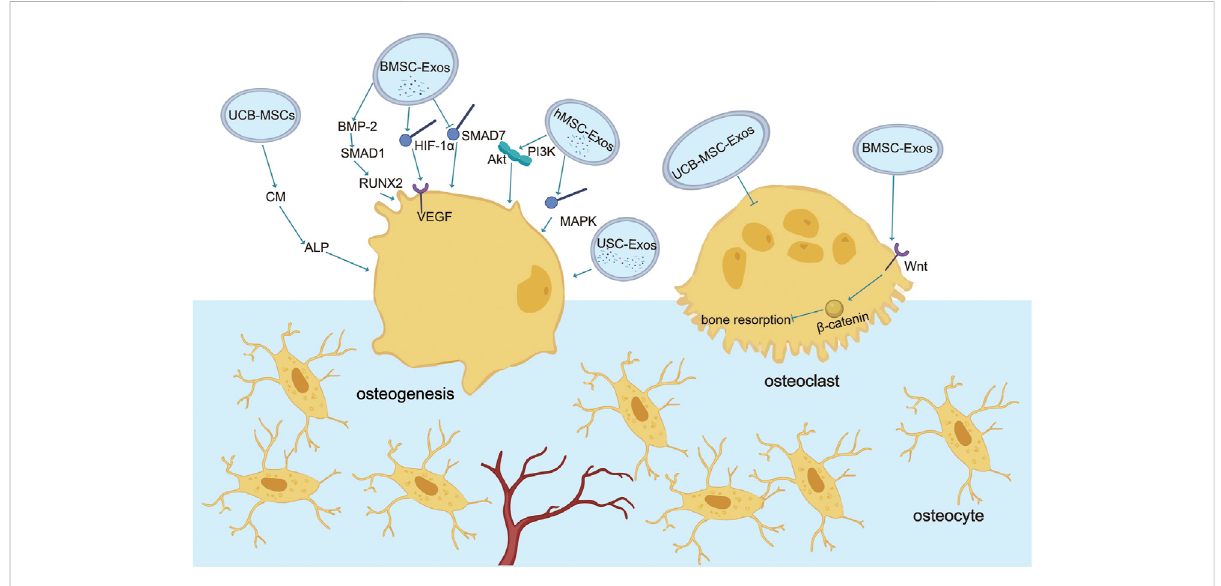
FIGURE 1 Role of exosomes in osteogenesis and osteoclasts. Various stem cell exosomes block osteoclast activation or directly differentiate into osteoblasts to regulate bone remodeling. Communication between osteoblasts and osteoclasts occurs through EVs. BMSC-Exos activate osteogenesisthroughBMP-2-SMAD1-RUNX2,HIF-1 α -VEGF,andSMAD7pathwaysandblockosteoclastogenesisthroughtheclassicWnt- β -catenin pathway. UCB-Exos activate ALP in human BMSC and the mRNA expression of type 1 collagen, RUNX2, osterix, and ALP in C3H10T1/2 cells. USC-ExosenrichosteogenesisandblockosteoclastogenesisbytransportingCTHRC1andOPG.hMSC-ExospromoteosteogenesisbyPI3K/Akt and MAPK.